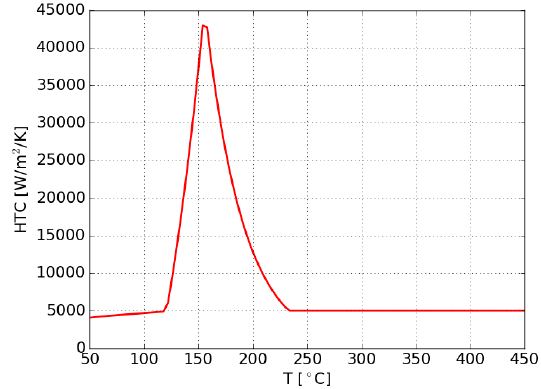
Figure 6. An example of the calculated HTC applied at the cooling channel in side die.